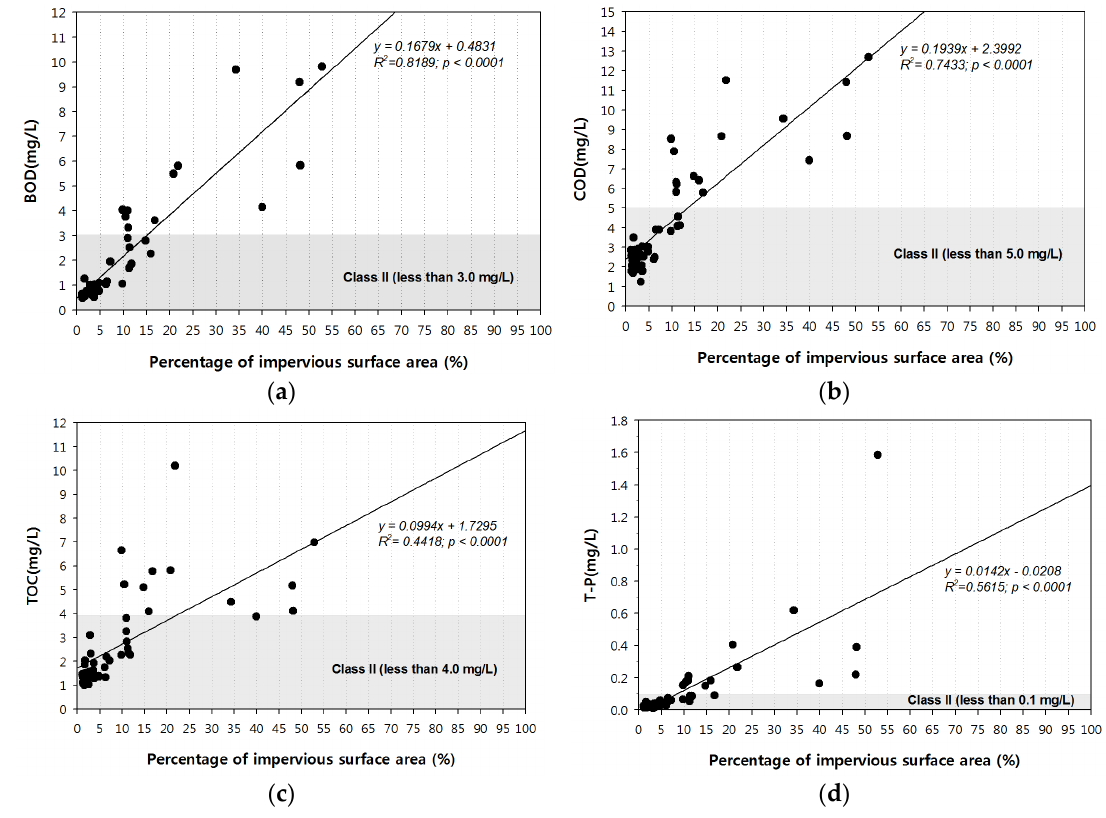
Figure 2. Plots of linear regression relationships of ( a ) BOD, ( b ) COD, ( c ) TOC, and ( d ) T-P in relation to the percentage of impervious surface area (PISA).